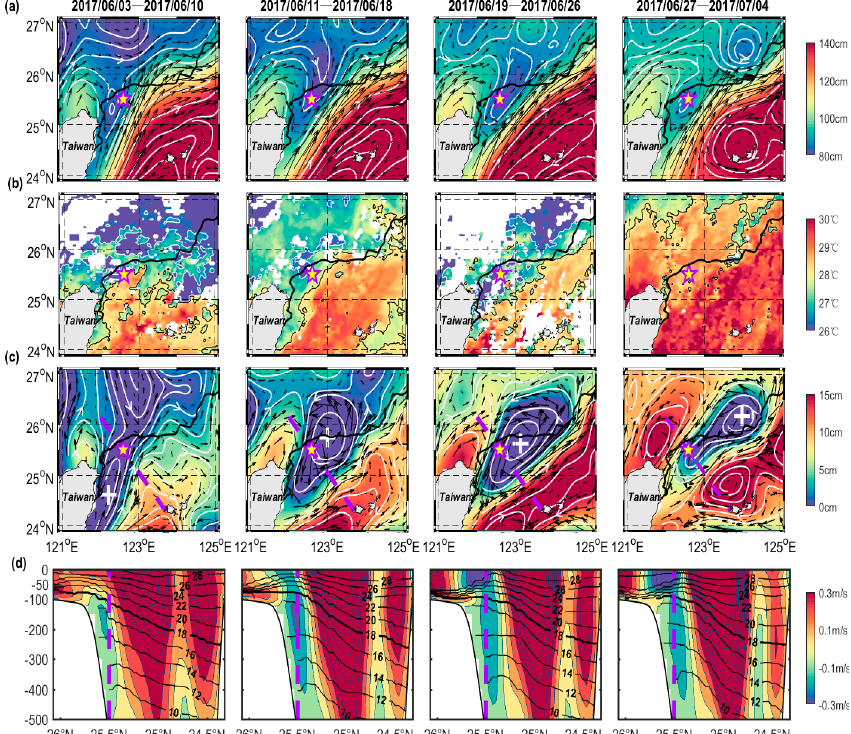
Figure 5. The horizontal absolute dynamic topography (ADT), geostrophic velocity (GV), sea level anomaly (SLA), geostrophic velocity anomaly (GVA) and sea surface Temperature (SST) distribution off northeastern Taiwan and the normal velocity distribution along section NL during an uplift case. ( a ) The horizontal ADT (colors) and GV (black arrows) distributions derived from satellite altimeter data. ( b ) The horizontal SST (colors) distributions derived from MODIS data, the white contours denote the 26.5 ◦ C isotherm, and the black contours denote the 28 ◦ C isotherm. ( c ) The horizontal SLA (colors) and GVA (black arrows) distributions derived from satellite altimeter data; the black line denotes the 200-m isobath, the in situ site is marked by a yellow star and the cyclonic GVA field center to the northeast of Taiwan is marked by a white ‘ + ’ symbol. ( d ) Vertical distribution of normal velocity (colors) along section NL (Figure 1) derived from the analysis data; the black solid lines denote isotherms, the black bold solid line denotes the 18 ◦ C isotherm, and the purple dashed line denotes the ADCP mooring